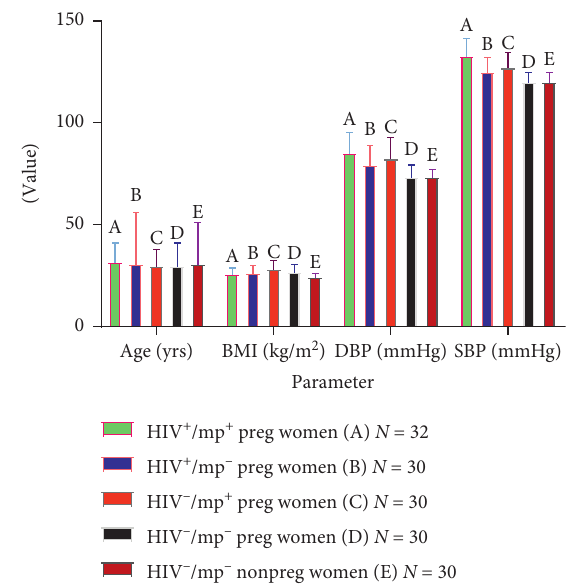
Figure 1: Comparison of the mean ( ± SD), age, body mass index, and blood pressure levels in the test group and control group. Key: BMI in A and B vs C and D ( p ≤ 0 . 001 respectively). BMI in A vs C ( p � 0 . 020). BMI in A and B vs E ( p ≤ 0 . 001). DBP in A and C vs B, D, and E ( p ≤ 0 . 001 respectively). B and C vs E ( p � 0 . 005 , p ≤ 0 . 001 respectively). C vs D ( p � 0 . 012). SBP in A, B, C, and D vs E ( p ≤ 0 . 001). A vs B ( p ≤ 0 . 001).C vs D ( p ≤ 0 .